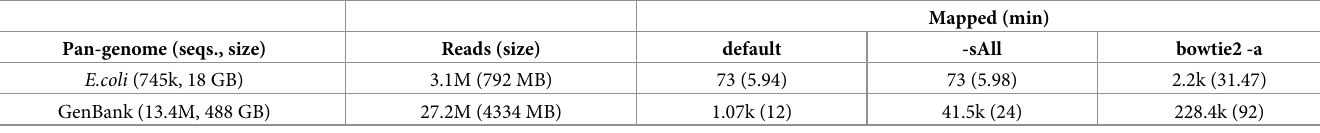
The CHIC aligner has been executed with three different parameter settings: default to find primary matches only, -sALL to find primary+secondary matches, and bowtie2 -a option (reports all approximate alignments) to find primary+secondary matches also from approximate read